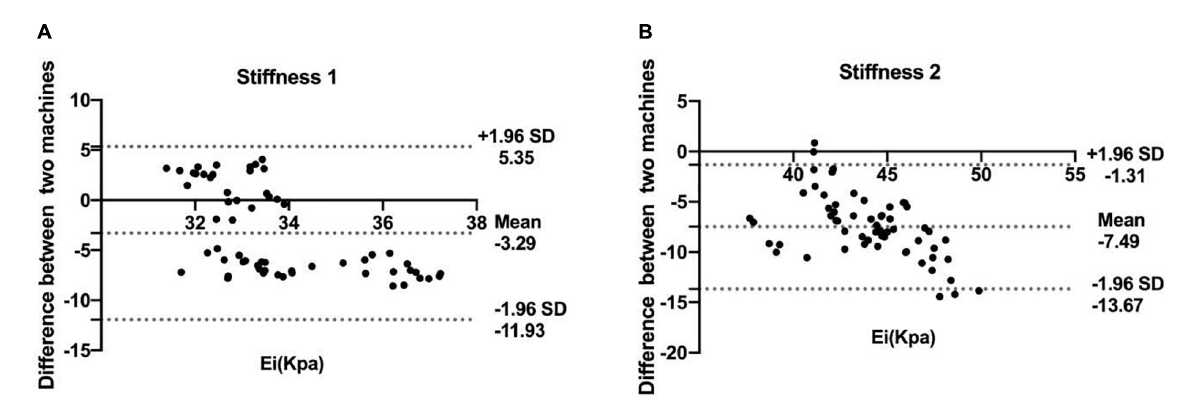
FIGURE2 Bland–Altman plots of the shear wave elastography (SWE) measurement values obtained by the two machines at stiffness 1 (A) and stiffness 2 (B) . The solid lines represent the mean difference in the SWE measurement values between two machines; the dashed lines define the LoA (mean of the differences ± 1.96